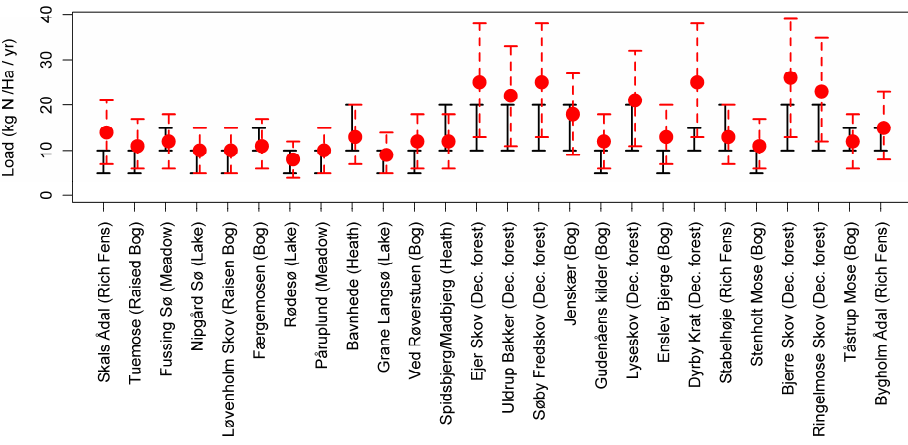
Fig. 9. The estimated N load with uncertainty interval (in red) to specific nature areas in the Aarhus region in Denmark, displayed in relation to the critical load levels corresponding to the dominating nature types.